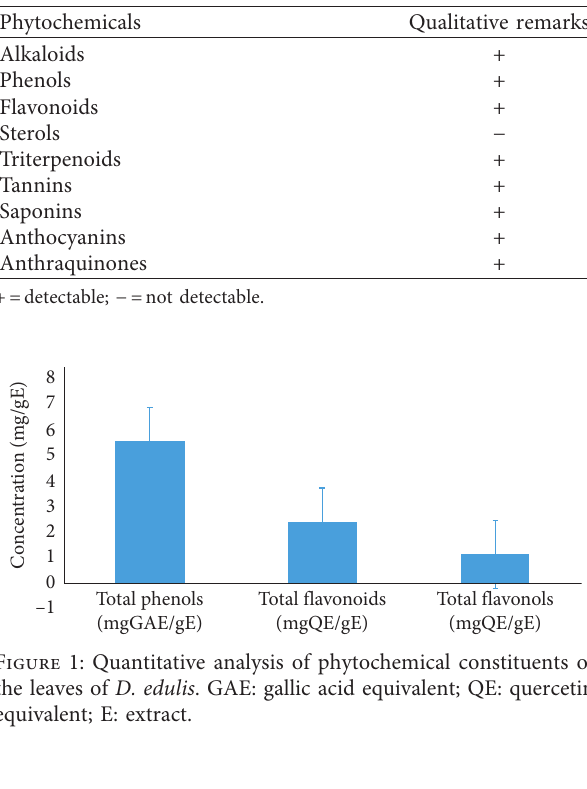
Table 1: Qualitative phytochemical analysis of the aqueous extract of D. edulis leaves.